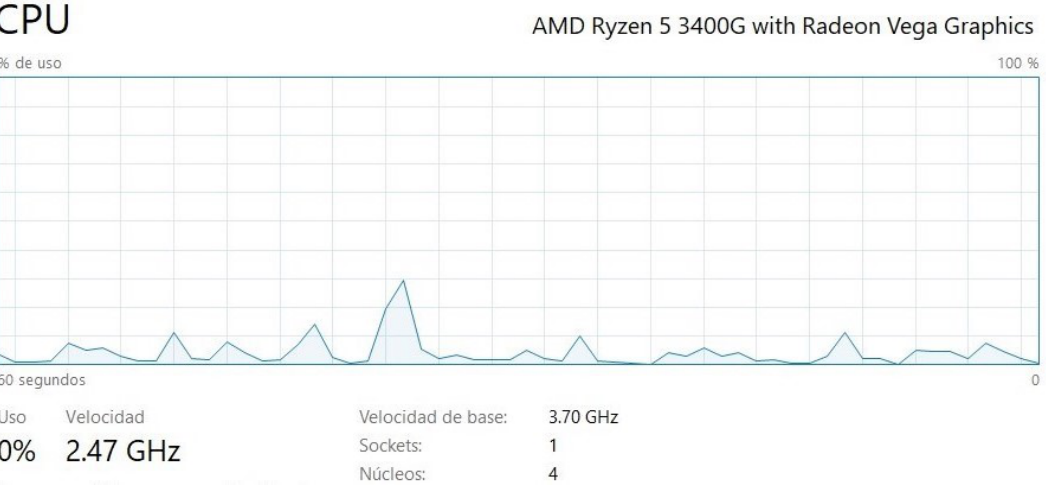
Figure 8. The CPU performance is lowest.